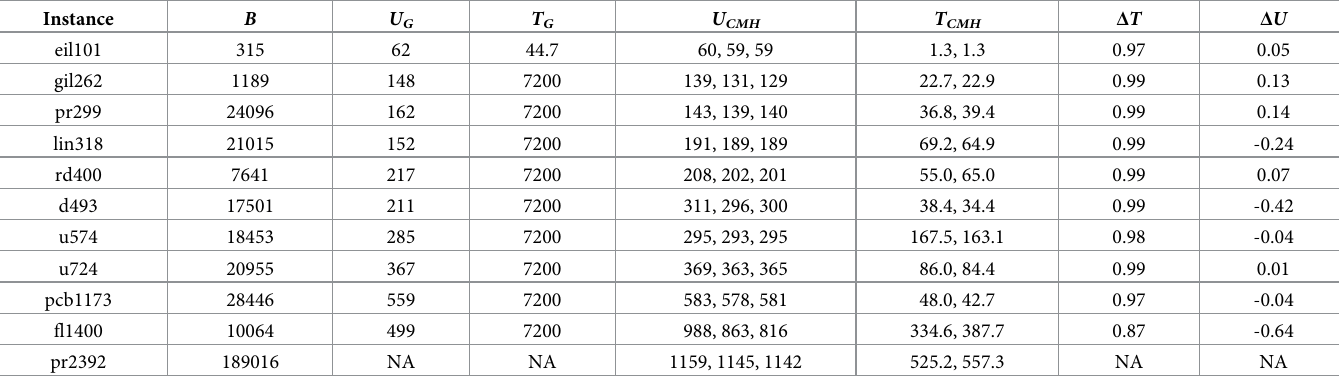
Table 3. Performance of Gurobi as standalone algorithm and when used in the clustering metaheuristic ( Flat instances). Instance B U